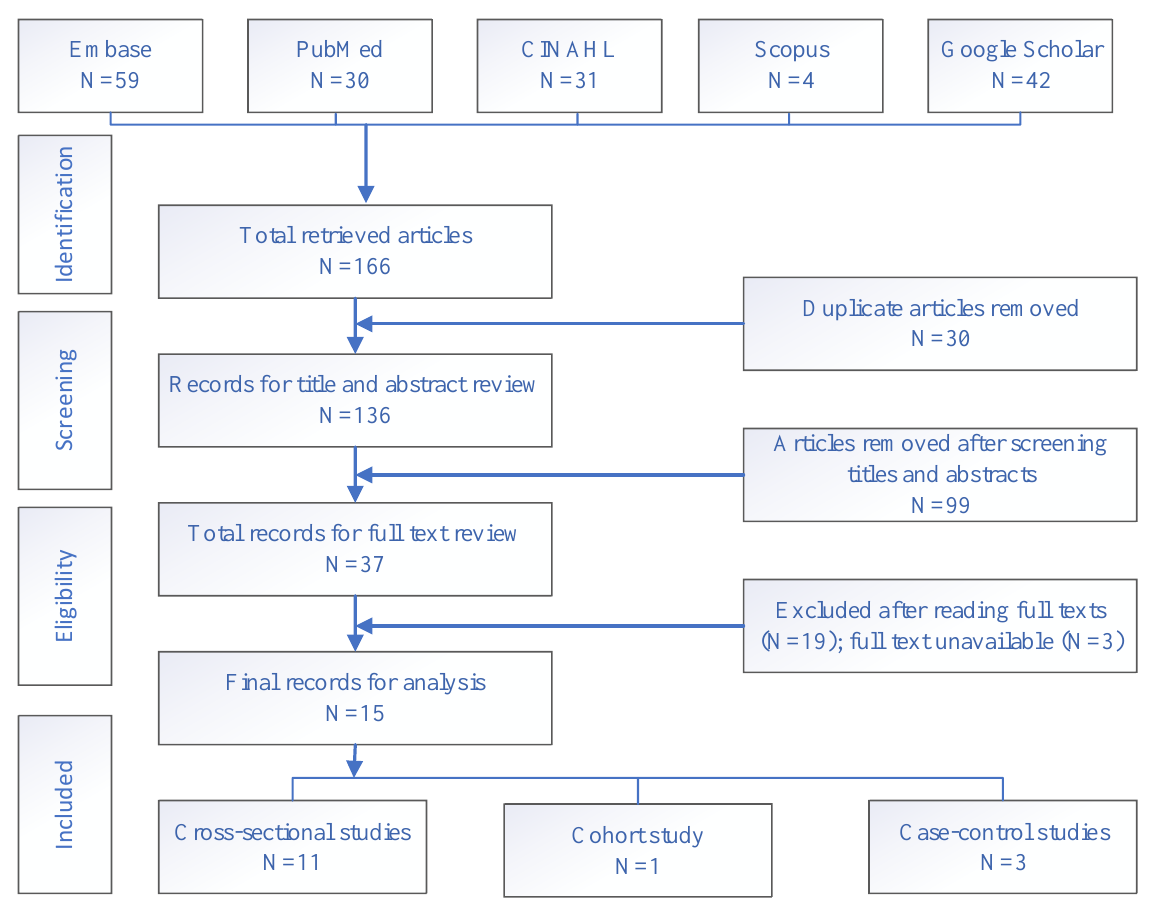
Figure 2. Flow chart for study selection based on PRISMA 2020